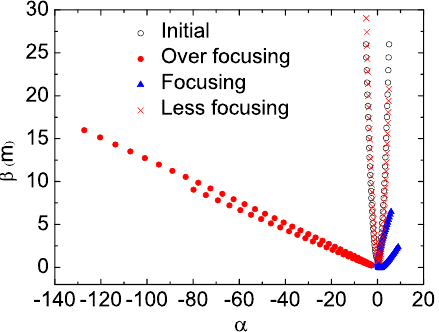
FIG. 6. Results from MOGA: Beta functions vs normalized